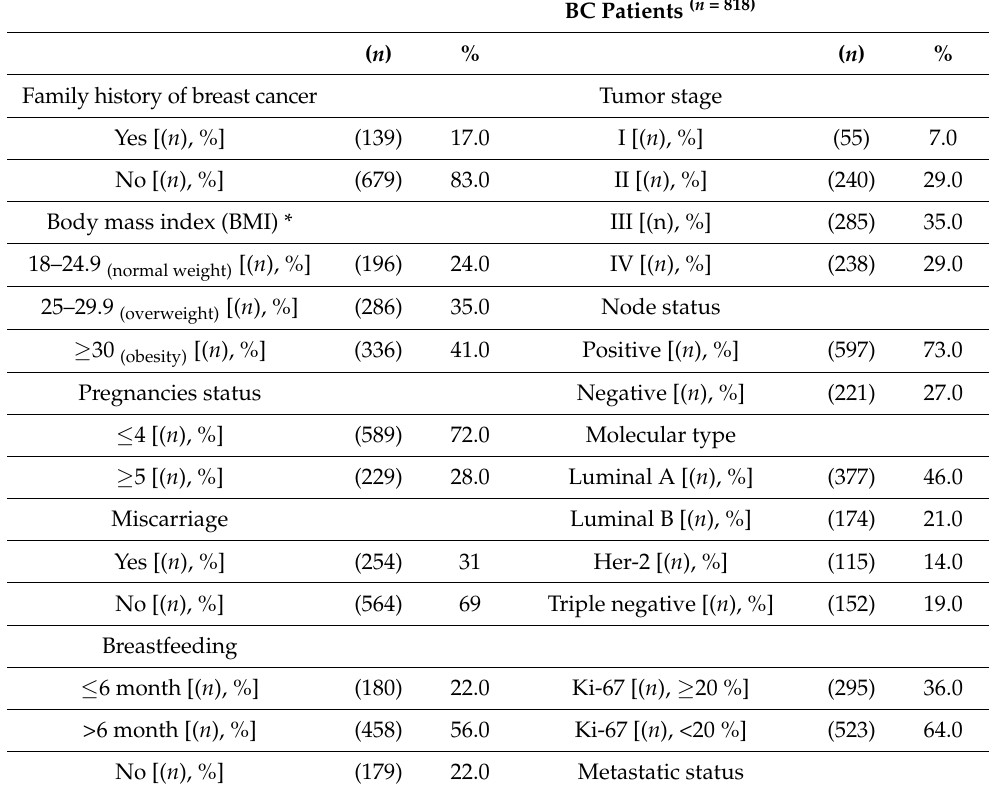
Table 2. Clinical data for the breast cancer